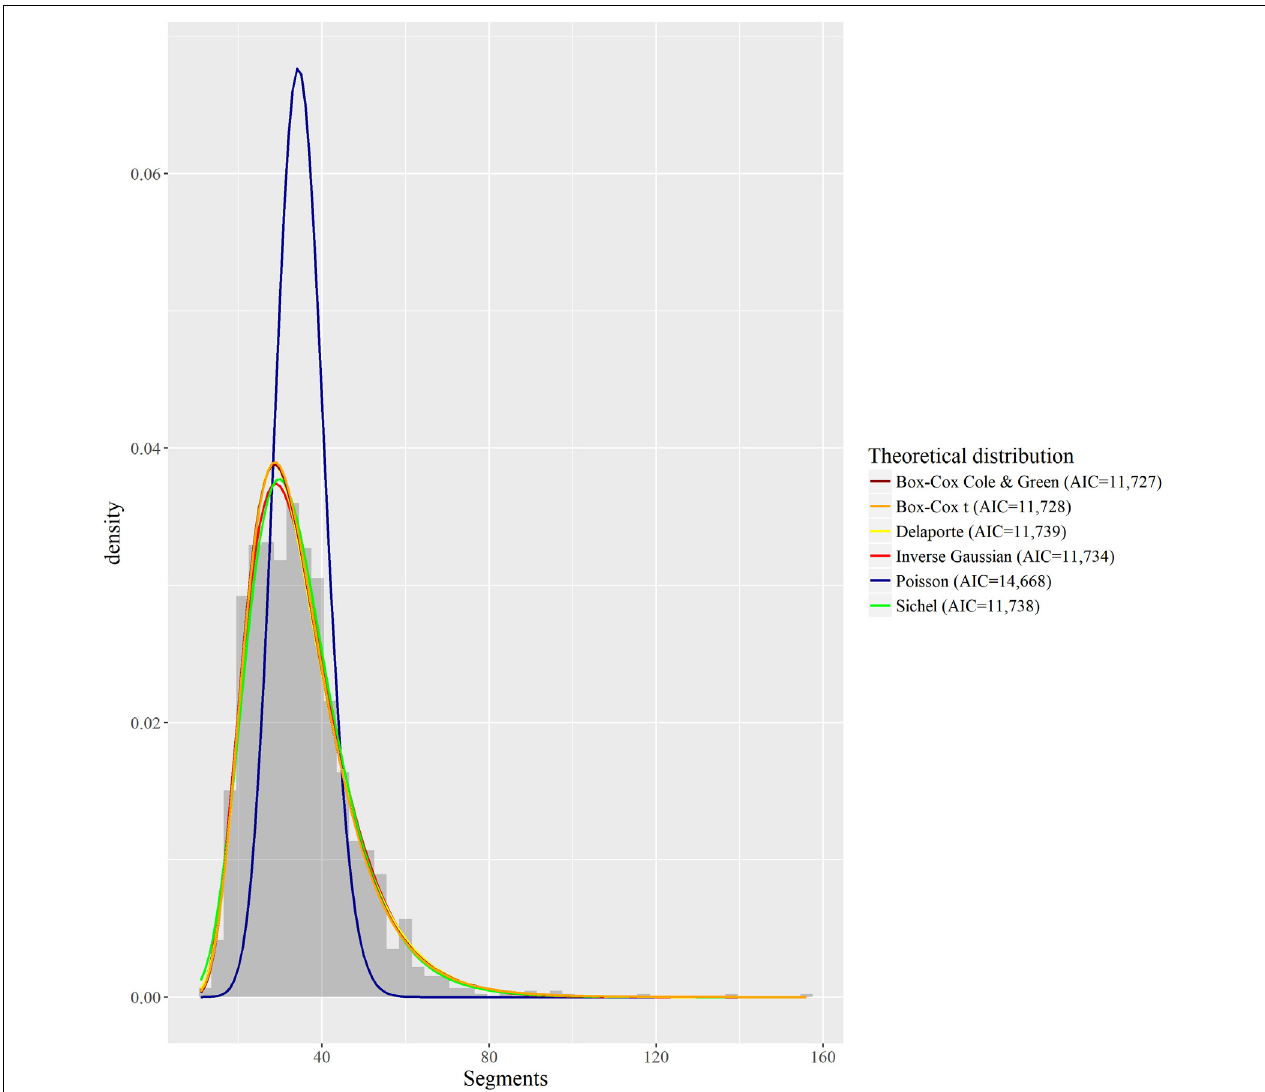
FIGURE 5 | Fitting of several discrete and continuous theoretical distributions to the empirical distribution of Phonemic inventory size